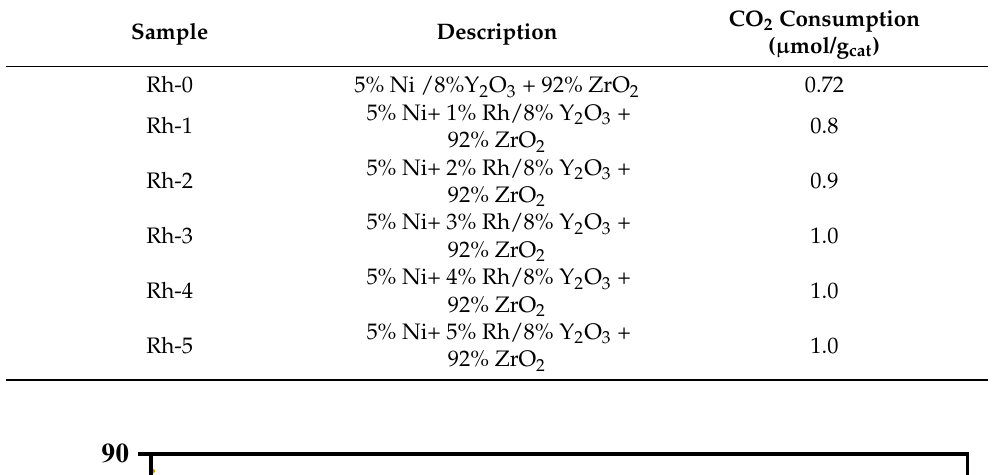
Table 3. H 2 consumption for promoted Rh 2 O 3 catalysts.